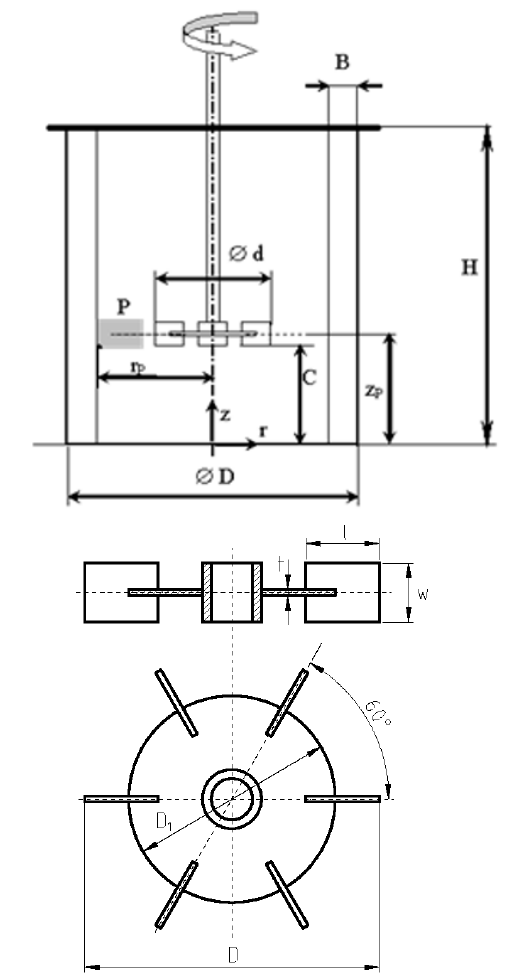
Fig. 1. Geometry of stirred vessel, and a sketch of Rushton turbine